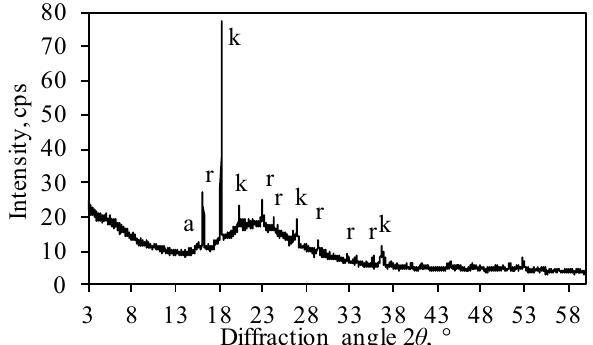
Figure 1. XRD pattern of silica gel waste. Indexes: k-gibbsite; r-aluminum trifluoride trihydrate; a-aluminum hydroxide fluoride